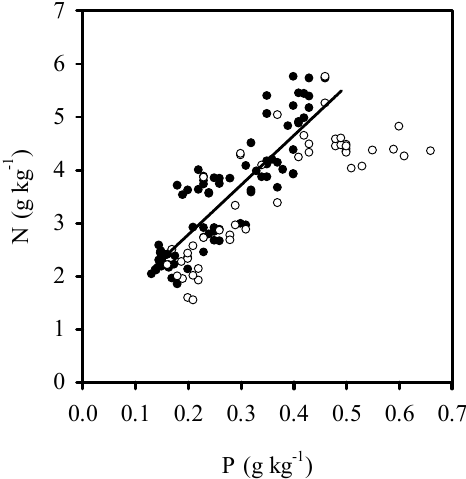
Figure 2. Relationship between P and N (g kg − 1 ) for observations where the L application had no impact on P (g kg − 1 ) ( ● ) and when L and L + G treatment increase P (g kg − 1 ) ( ◯ ). Regression equation for the relationship for ● observations is N (g kg − 1 ) = 0.8 + 10.0 × P (g kg − 1 ), r 2 = 0.78 ( p < 0.0001) and for all observations is N (g kg − 1 ) = 1.4 + 7.0 × P (g kg − 1 ), r 2 = 0.63, line not presented.